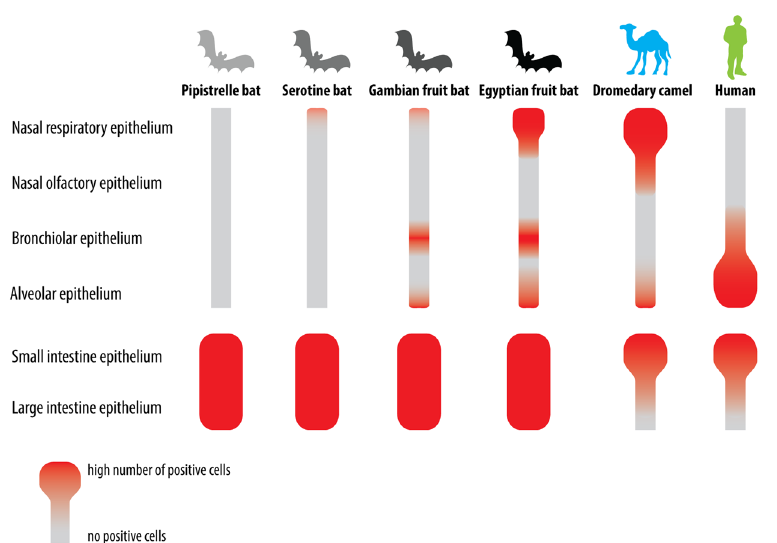
Figure 3. Different distribution of DPP4 expression in the lining respiratory tract and intestinal epithelium of the common pipistrelle bat, serotine bat, Gambian fruit bat, Egyptian fruit bat, dromedary camel, and human. In the common pipistrelle bat and serotine bat, DPP4 is limitedly detected in the respiratory tract and mainly expressed in the intestinal epithelium. In the Gambian and Egyptian fruit bat, DPP4 is found both in the respiratory tract and in the intestinal epithelium. In the dromedary camel, it is expressed in the upper respiratory tract and small intestine epithelium. In the human, it is predominantly expressed in the lower respiratory tract and small intestine